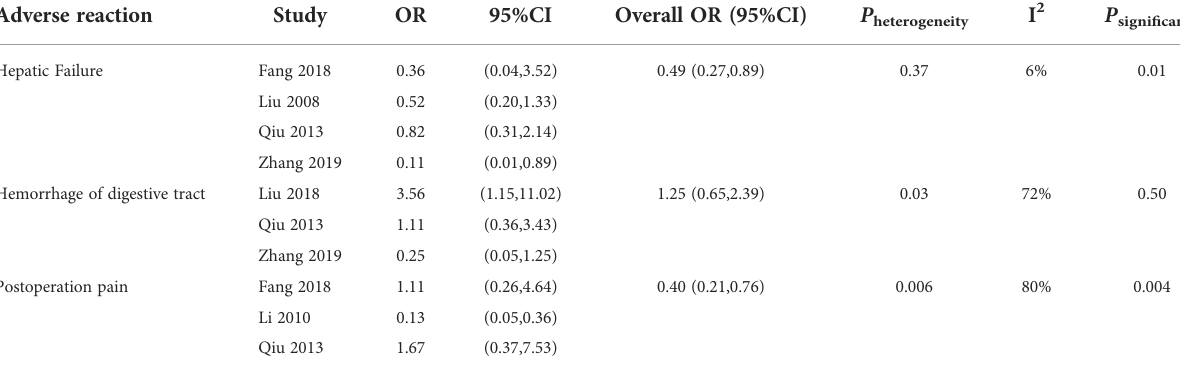
TABLE 4 Results of heterogeneity analysis of adverse reactions. Adverse